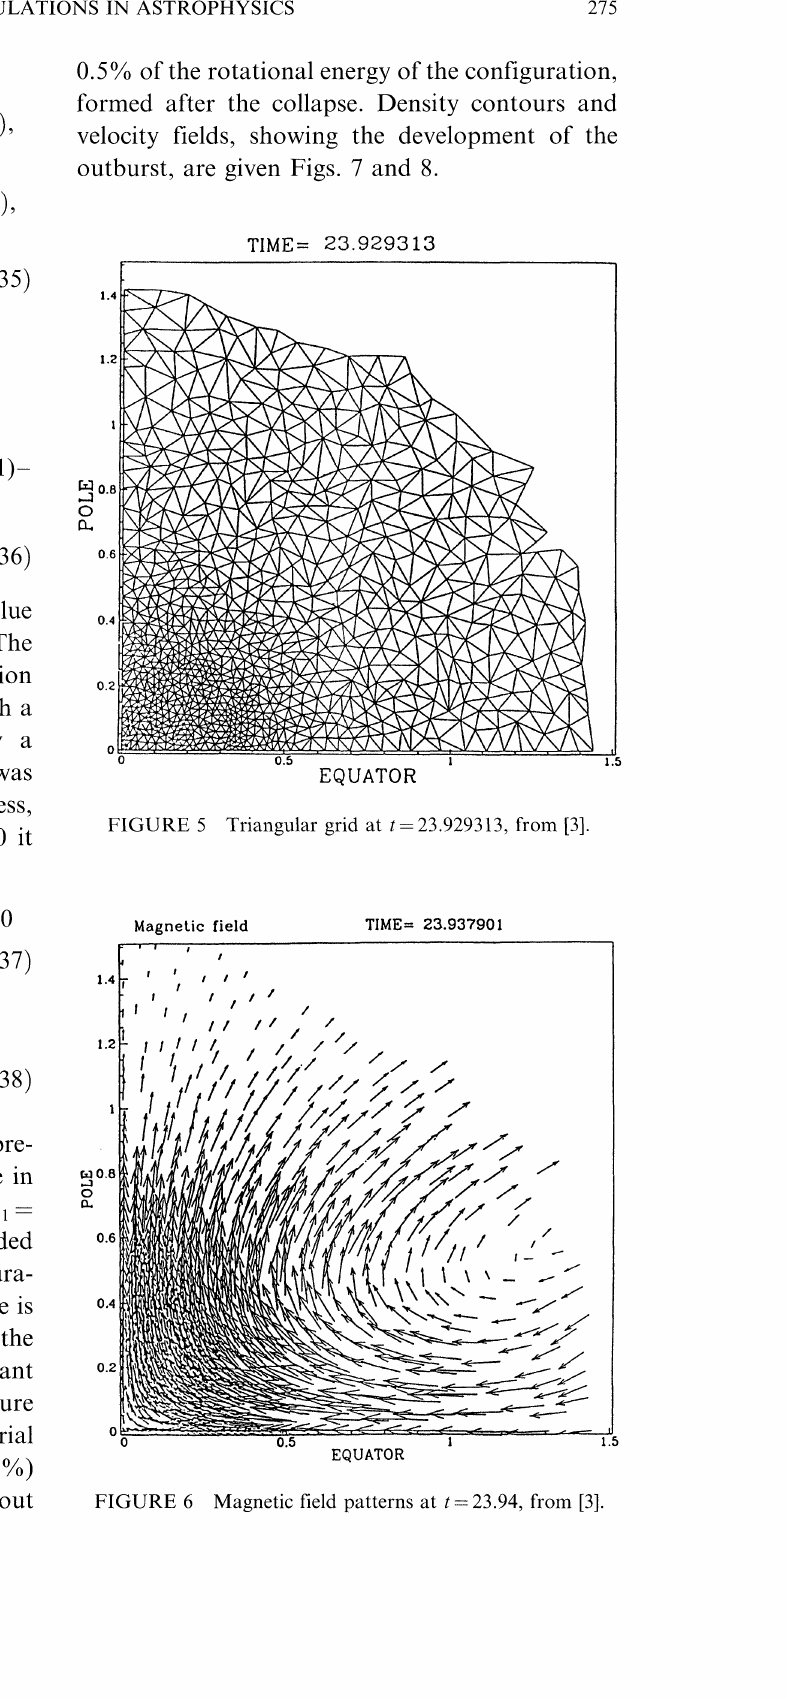
FIGURE 6 Magnetic field patterns at 23.94, from